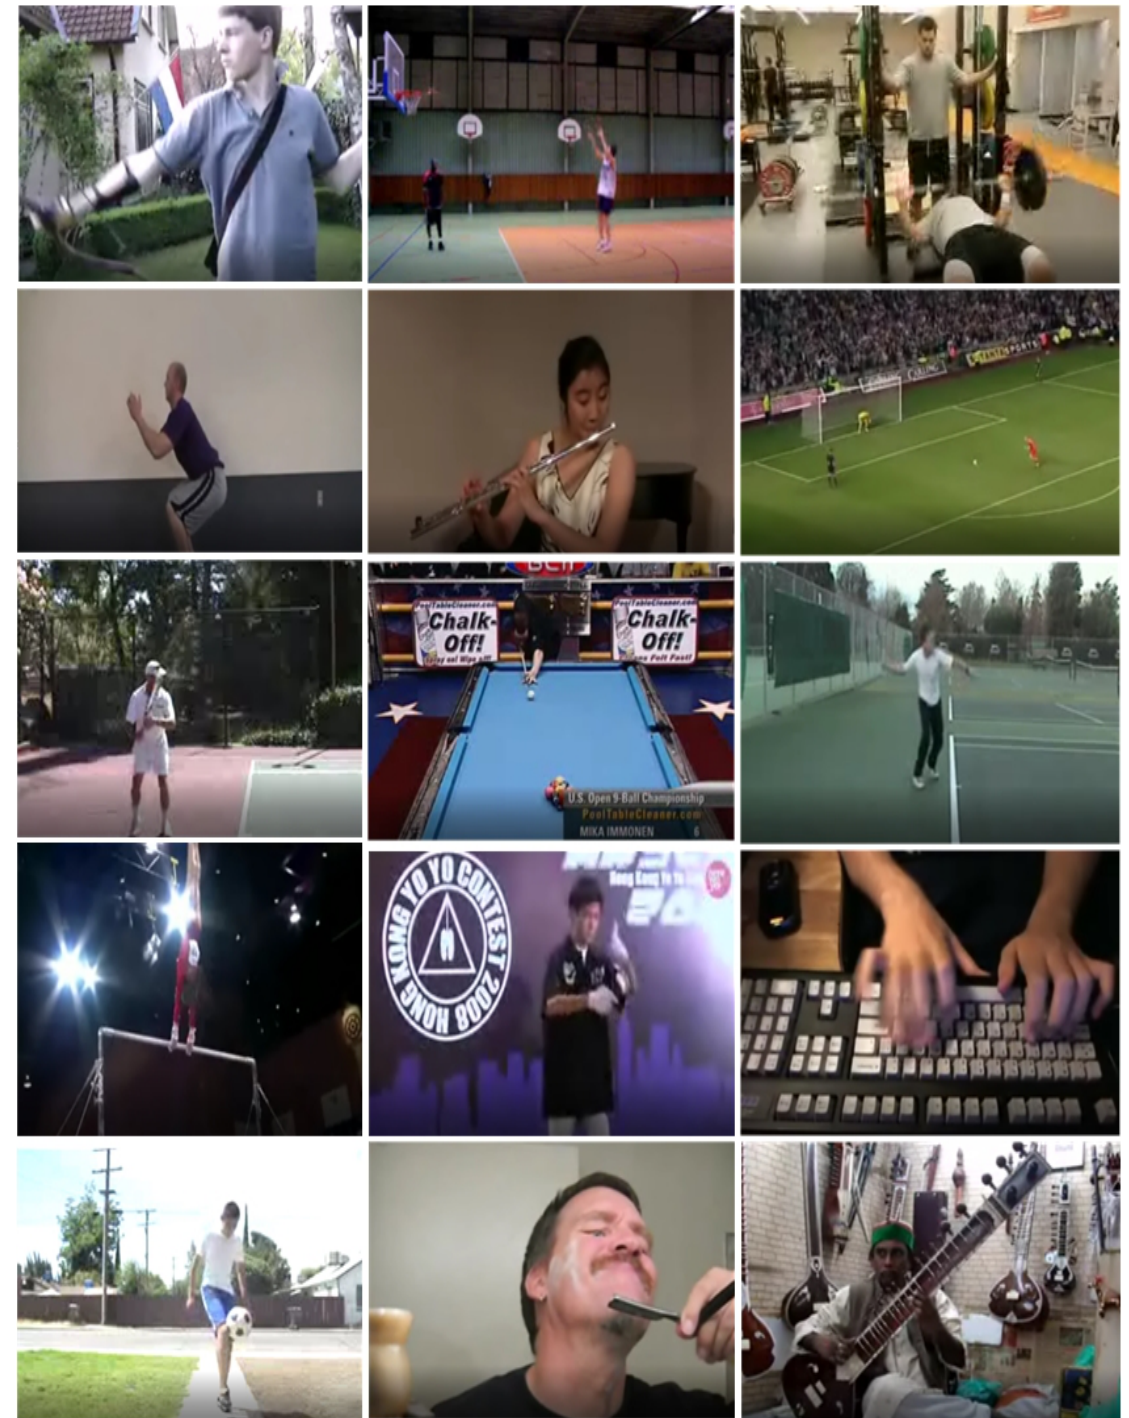
Figure 9. Generated high-resolution frames of the raw